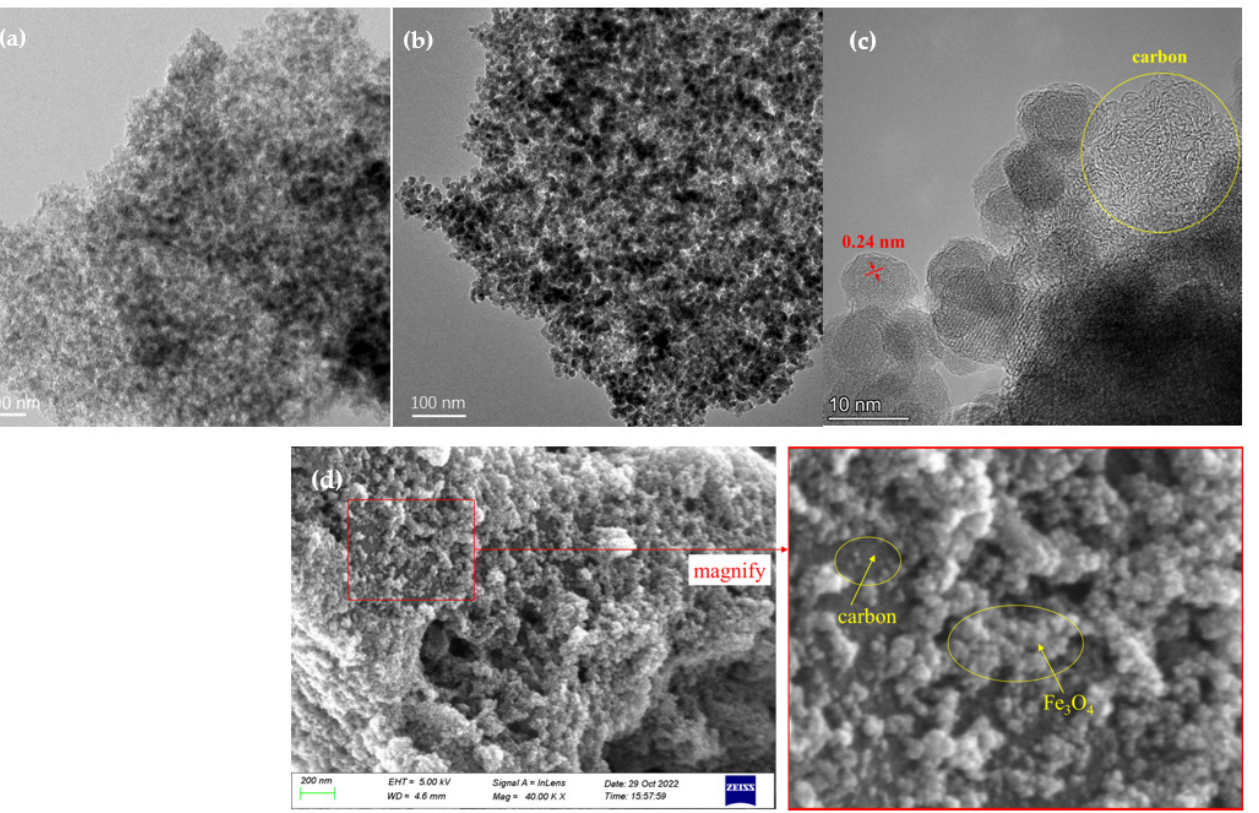
Figure 2. FTIR spectrum ( a ) and XRD patterns ( b ) of MMC and MOMMC.